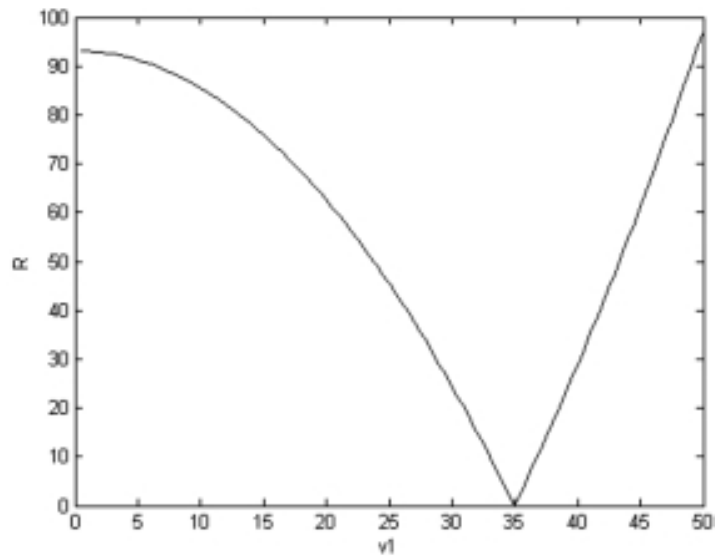
Fig. 4. Determination of initial velocity v 1 .